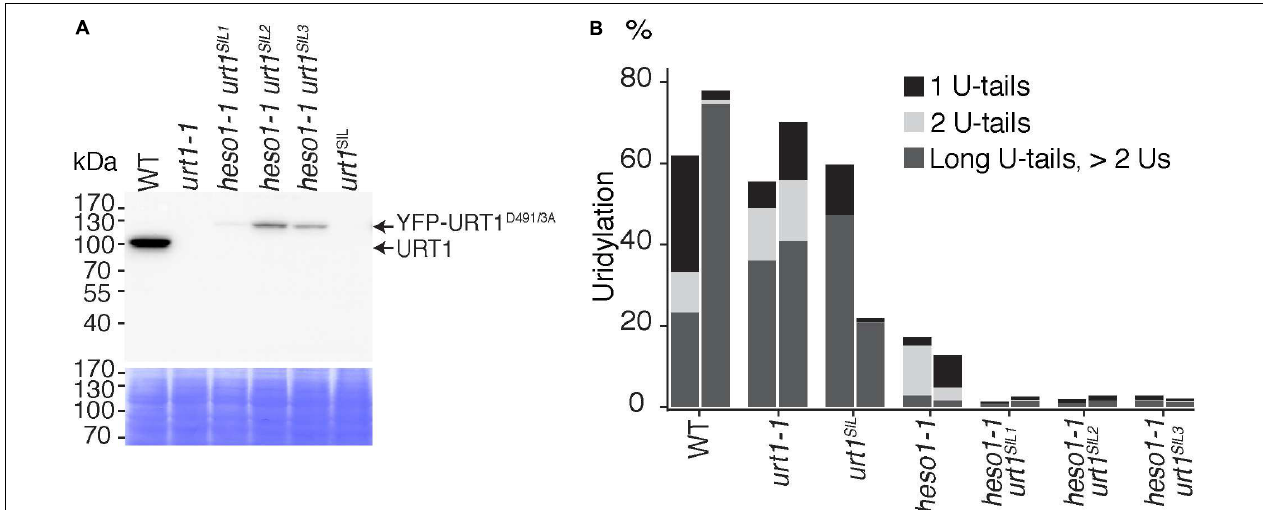
FIGURE 4 | Respective contributions of HESO1 and URT1 in the uridylation of MYB33 RISC 5 (cid:48) -cleavage fragments. (A) Western blot analysis of WT, urt1-1 T-DNA mutant, co-suppressed urt1 mutant ( urt1 SIL ), and three double mutant lines heso1-1 urt1 SIL . Molecular weight markers are indicated in kDa. A portion of the membrane stained with Coomassie blue is shown as loading control. Please note that the construct used to co-suppress URT1 in the heso1-1 background expresses an inactive version of URT1 fused to YFP. Uncropped images are shown in Supplementary Figure S1 . (B) Percentages of uridylated MYB33 RISC 5 (cid:48) -cleavage fragments in two biological replicates for WT, urt1-1 , the urt1 SIL line, heso1-1 , and the three heso1-1 urt1 SIL lines (i.e., six heso1-1 urt1 SIL samples). Percentages of long ( > 2 Us), 2 U- and 1 U-tails are indicated by dark gray, light gray, and black, respectively.